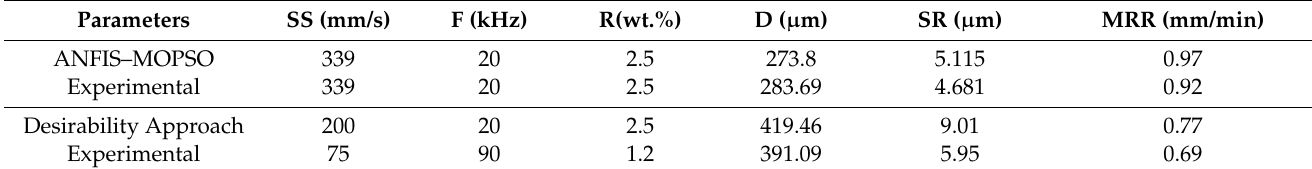
Table 11. Validation experiments of ANFIS–MOPSO and desirability methods.